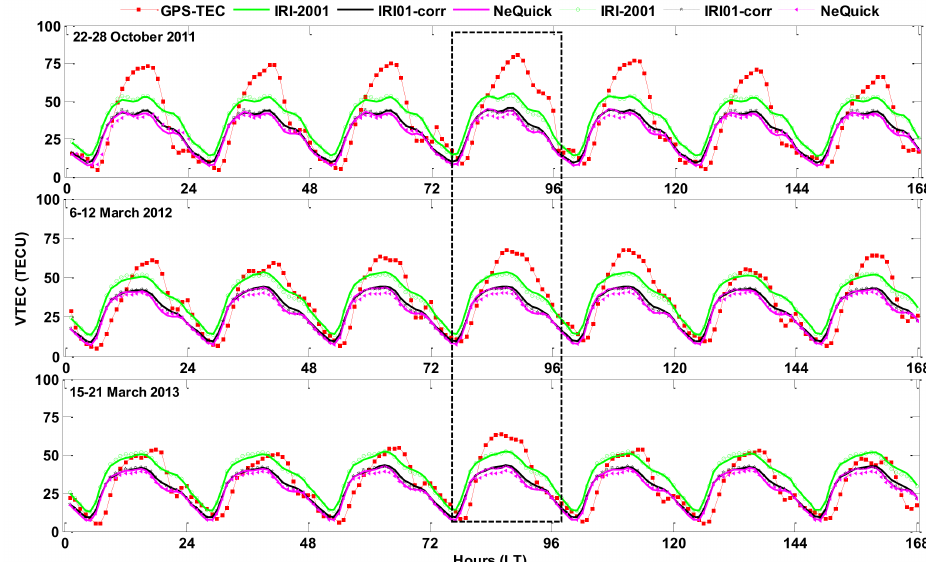
Figure 7. The daily variation of the measured and modelled VTEC during the disturbed period. The IRI-2016 (IRI-2001, IRI01-corr, and NeQuick) are plotted in solid lines and the IRI-2012 (IRI-2001, IRI01-corr, and NeQuick) are plotted in dotted lines.